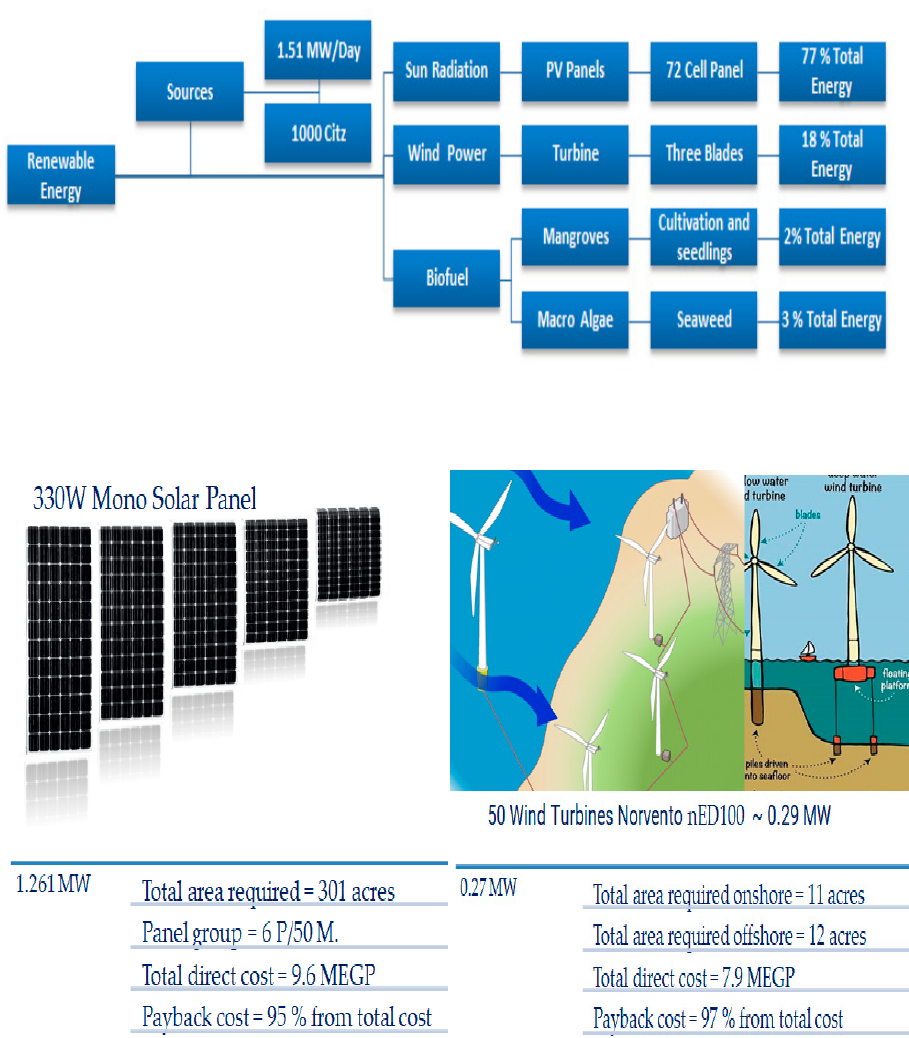
Figure 5. Energy harvesting from PV, wind in WD